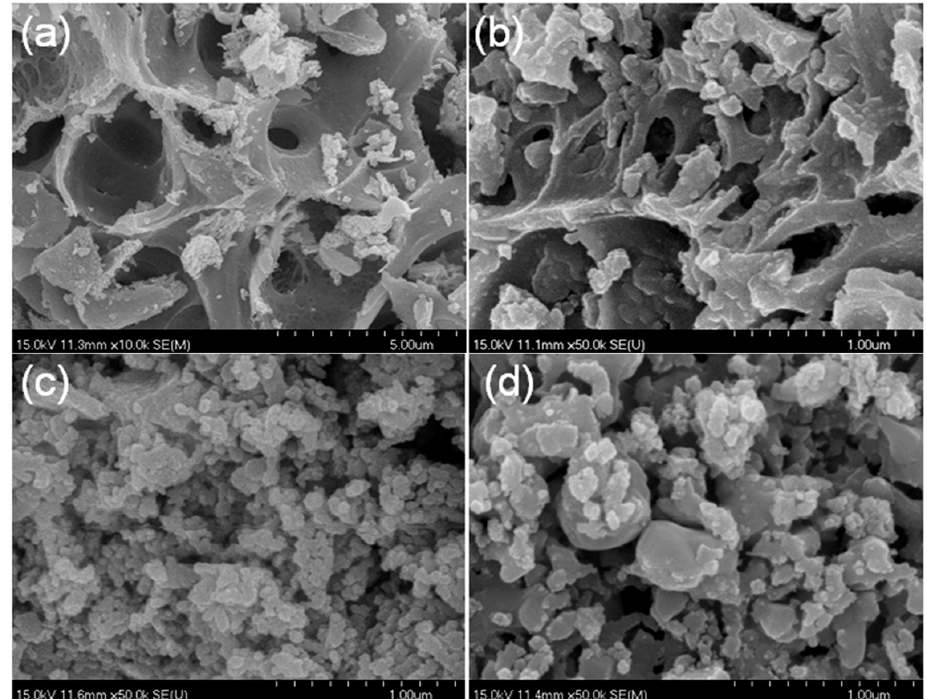
Figure 4. SEM images of the CoCe–X catalysts: ( a ) CoCe–MA; ( b ) CoCe–CA; ( c ) CoCe–GA; and ( d )